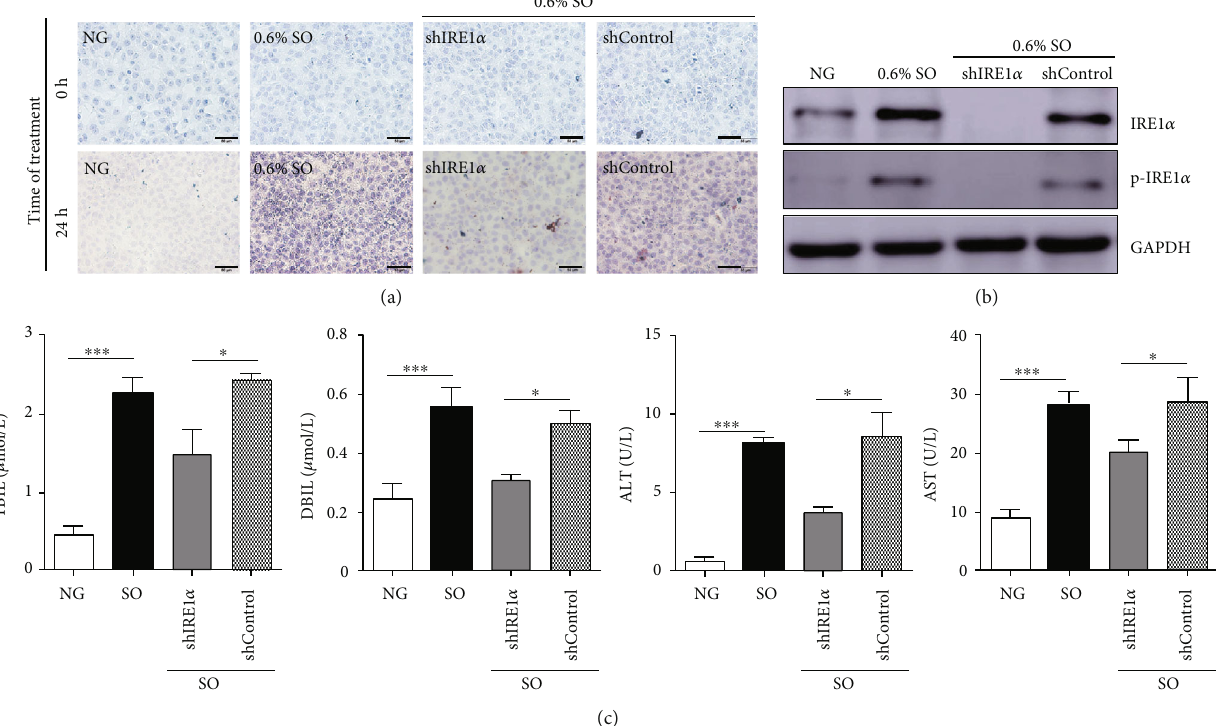
Figure 4: IRE1 α suppression attenuated the steatosis in BRL cells. (a) The representative images of Oil Red O staining in BRL cells in di ff erent groups as indicated. Scar bar: 50 μ m. (b) The protein expression was detected by western blotting. GAPDH was loaded as an internal control. NC indicated BRL cells not infected with any virus. (c) Biochemical parameters (TBIL, DBIL, ALT, and AST) of BRL cells in di ff erent groups as indicated. NG: not given (BRL cells untreated with SO). The data was presented as mean ± SD , ∗ P < 0 : 05 , ∗∗∗ P < 0 : 001